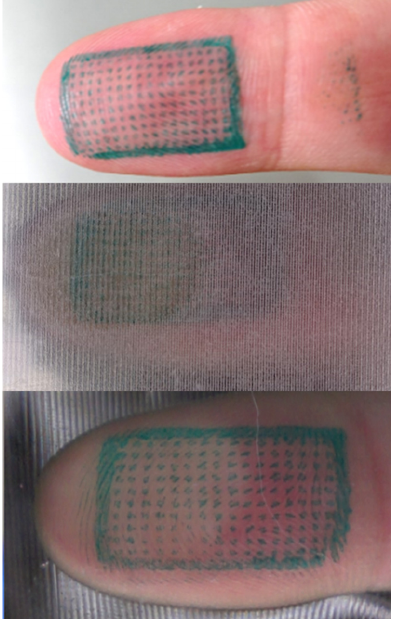
Figure 1. Top: fingertip with markers; middle: fingertip viewed through the textured surface without oil; bottom: fingertip viewed through the textured surface submerged in oil.